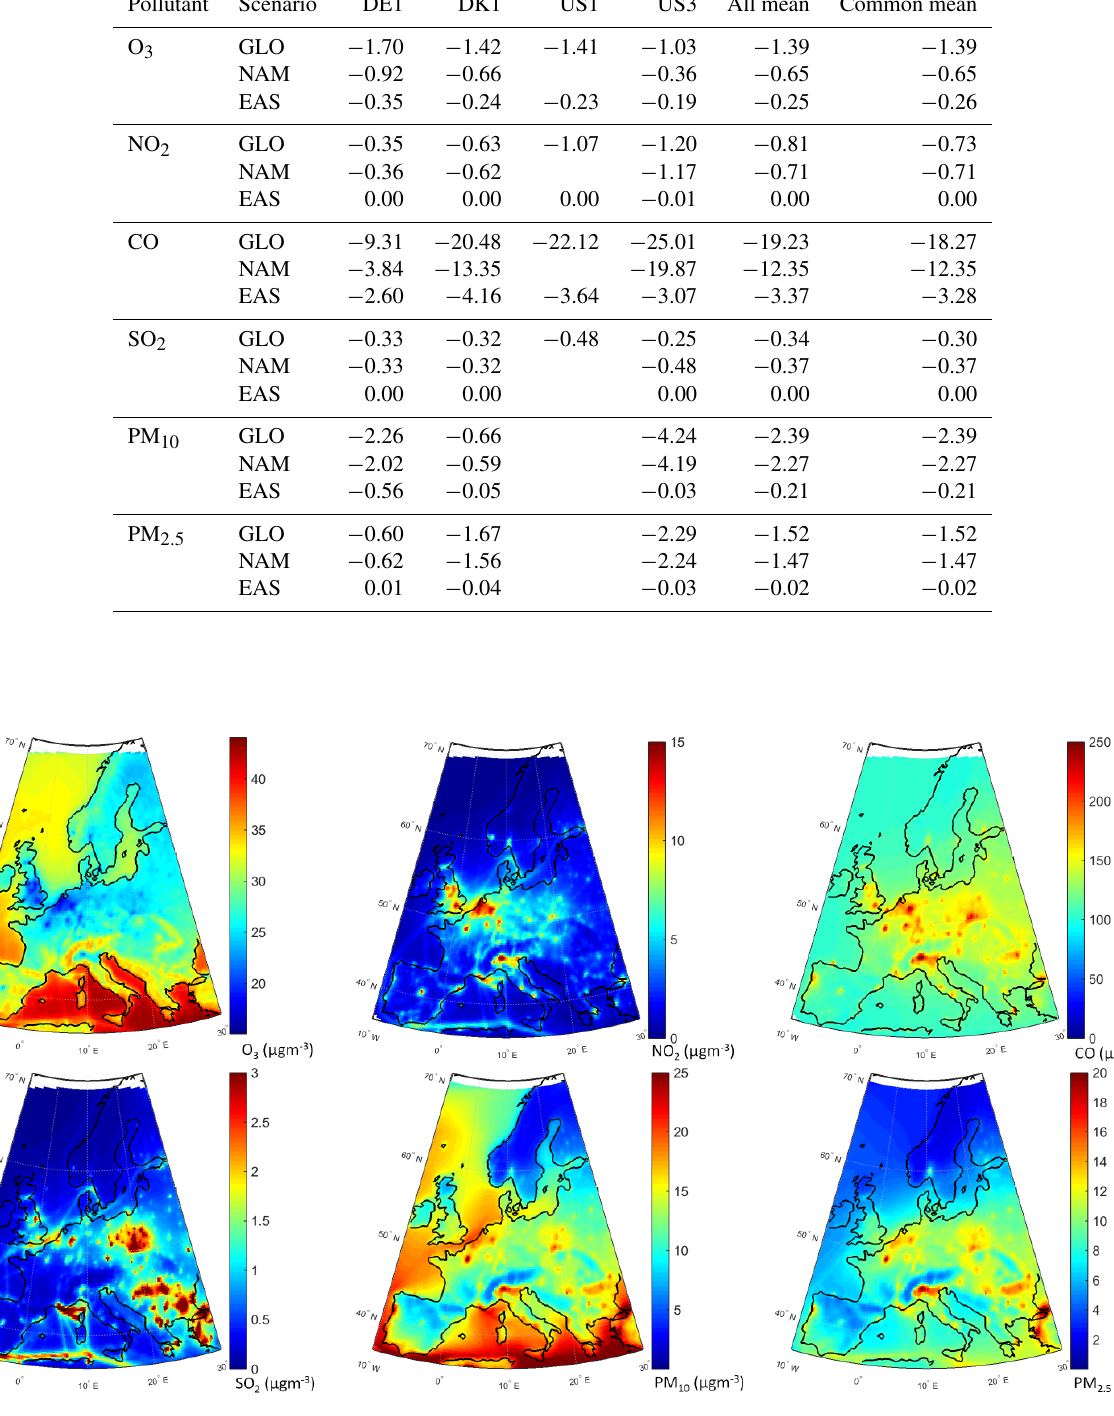
Figure 3. Multi-model mean air pollutant levels over Europe as simulated in the base